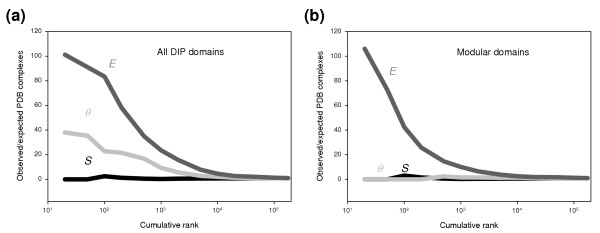
Enrichment of PDB complexes in highest-ranking domain pairs predicted to interact. Ratio of observed/expected PDB complexes in each sample of domain pairs is plotted against cumulative rank. For example, the top 100 domain pairs ranked by E have 71-fold more PDB complexes than would be expected in 100 randomly chosen potentially interacting domain pairs in DIP. Potentially interacting domain pairs were ranked by each of three measures: S, θ and E. (a) Ranking all domain pairs by their frequency of co-occurrence in interacting protein pairs, S, yielded no significant enrichment of PDB complexes at any rank cutoff. A significant enrichment of PDB complexes was seen when domain pairs were ranked by θ, and even more so ranked by E, as shown by the successive increase in observed/expected PDB complexes at each cumulative rank. The ratio using all three measures approaches 1.0 as the number of ranked complexes approaches total number of predictions in the dataset. Our results suggest that the E score output by DPEA performs better than S or θ at identifying physically interacting domain pairs. (b) Ranking interactions of modular domains by E reveals enrichment of PDB complexes. No enrichment is found when interactions are ranked by θ or S.